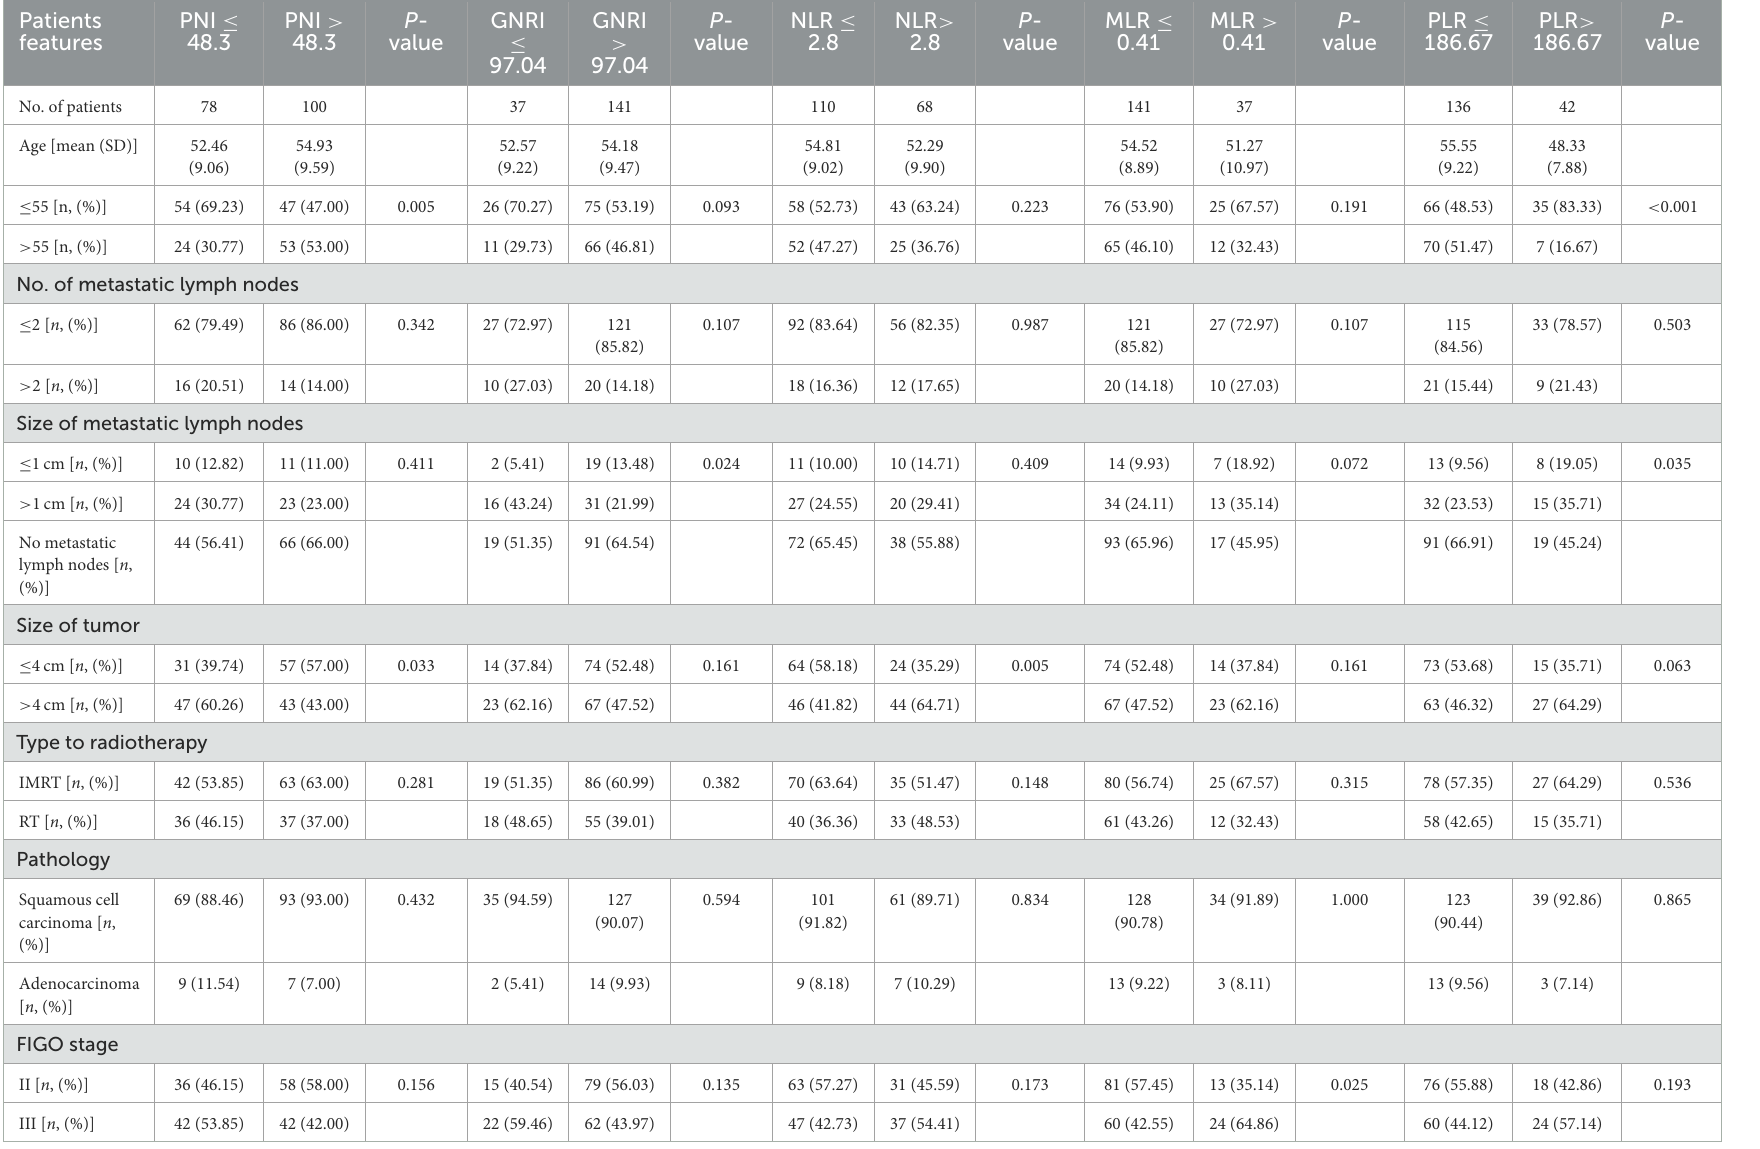
TABLE 1 The baseline characteristics of 178 patients with cervical